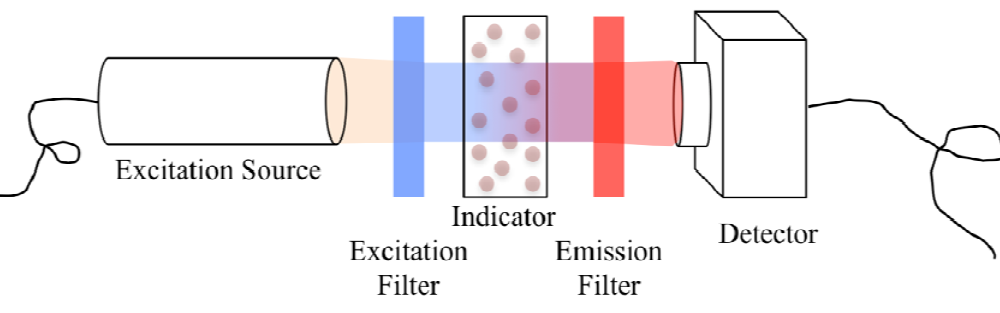
Figure 1. Simplified example setup for intensity-based optical oxygen